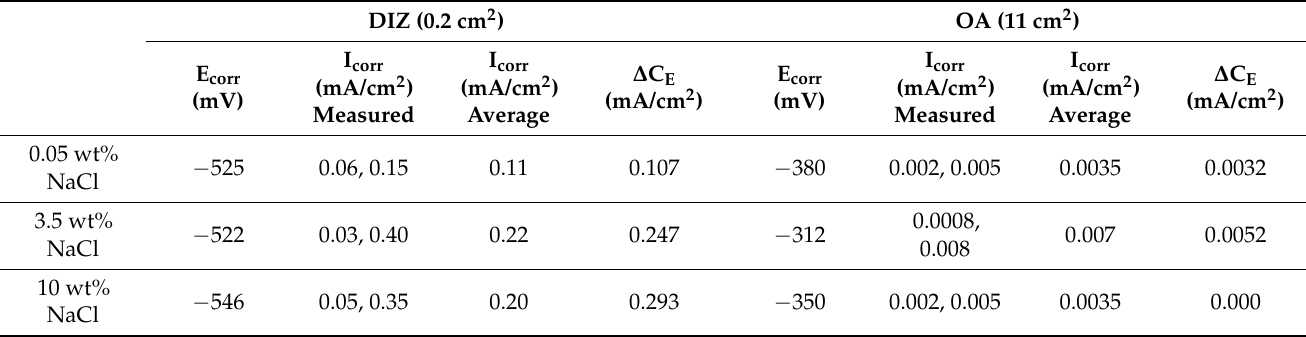
Table 9. Electrochemical measurements for UNS S32760 segmented sample in all test salinities.